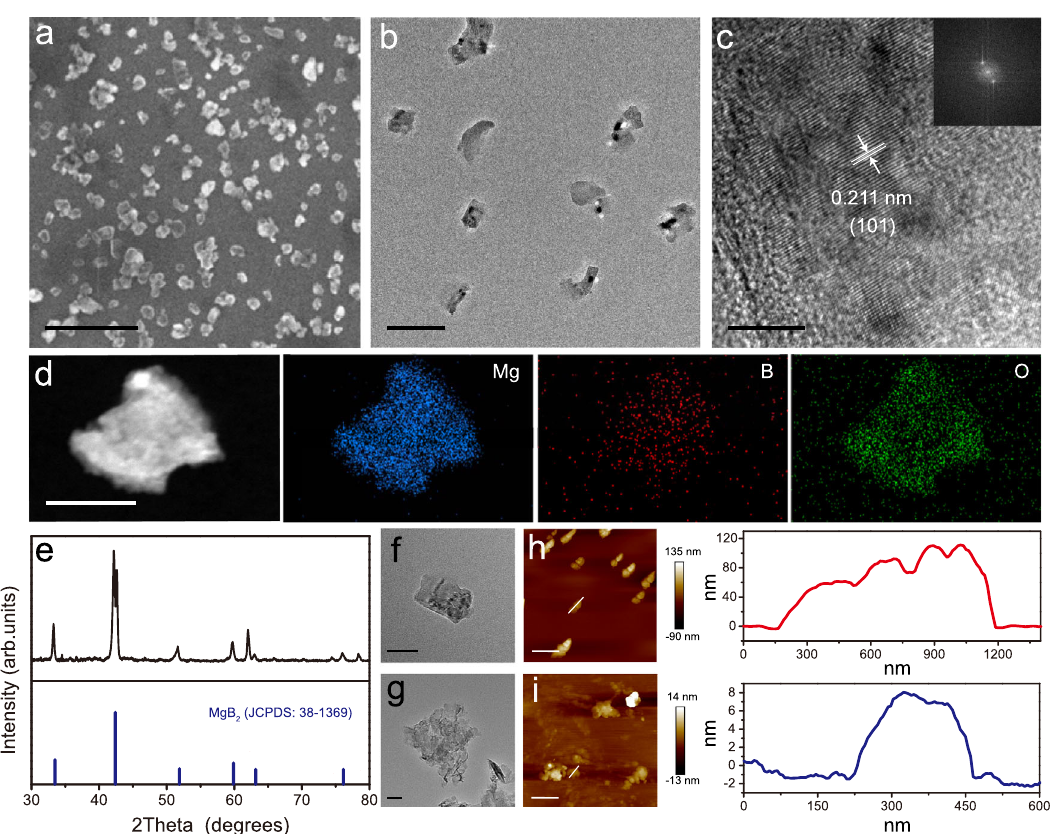
Fig. 2 | Morphology and characterization of Nano-MgB 2 . a SEM image of Nano- MgB 2 . Scale bar=500nm. b TEM image of Nano-MgB 2 . Scale bar=200nm. c HRTEMimageofNano-MgB 2 .Scalebar=5nm.Insetgraph:fastFouriertransform imageofNano-MgB 2 . d HADDF-STEMandEDSelementalmappingimagesofNano- MgB 2 .Scalebar=100nm. e XRDpatternsofNano-MgB 2 . f , g TEMimagesofasingle